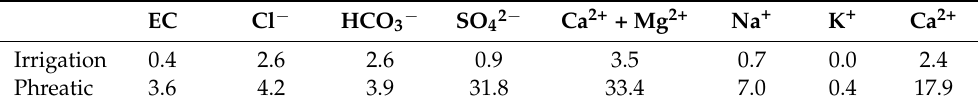
Table 3. Mean composition of the waters analyzed in the IRYDA report [1]: electrical conductivity (EC, dS m − 1 ) and ionic concentrations (meq L − 1